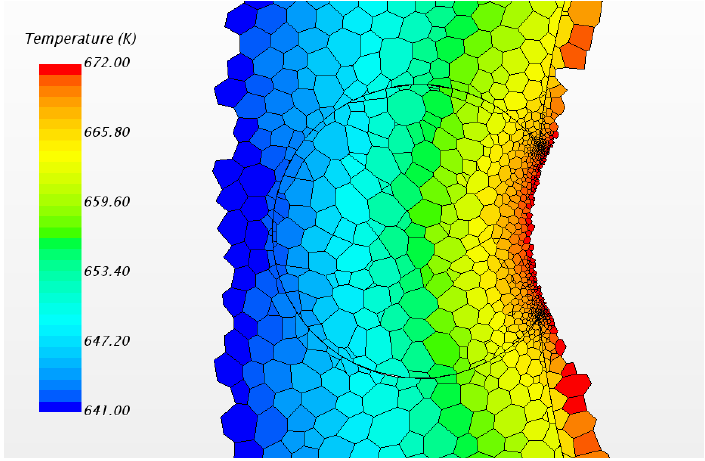
Figure 17. Local temperature field of wrapping wire .